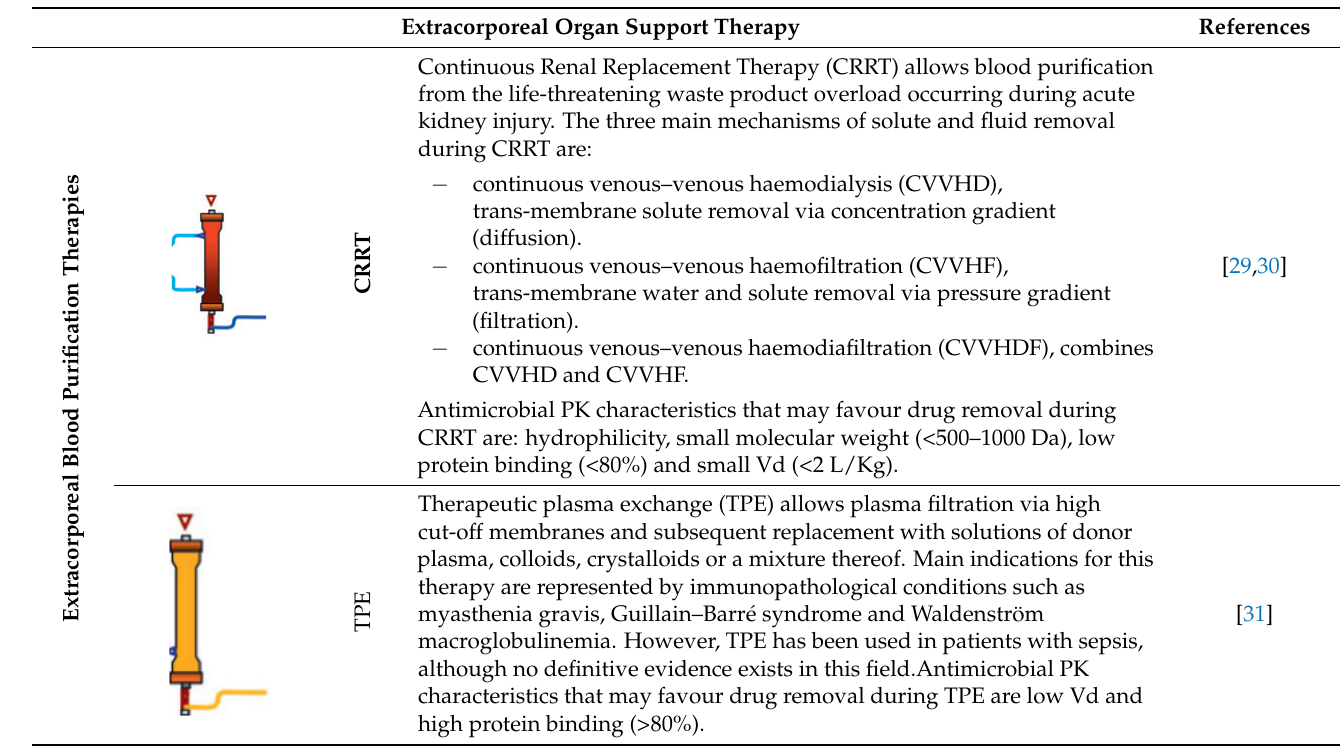
Table 2. Extracorporeal Organ Support Therapy.